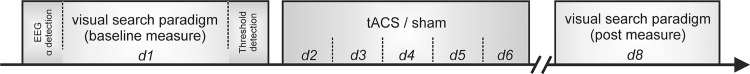
Experimental protocol.